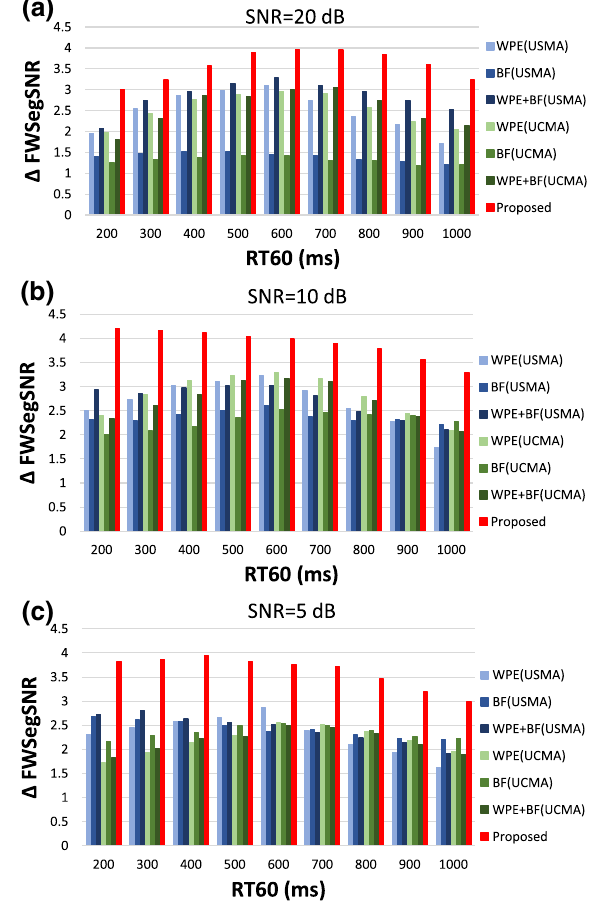
Fig. 10 (cid:31) FWSegSNR changes in proportion to RT60 for beamforming (BF), dereverberation (WPE) and their combination (WPE BF) with the USMA and the UCMA geometries in comparison to the proposed + approach in three noise levels